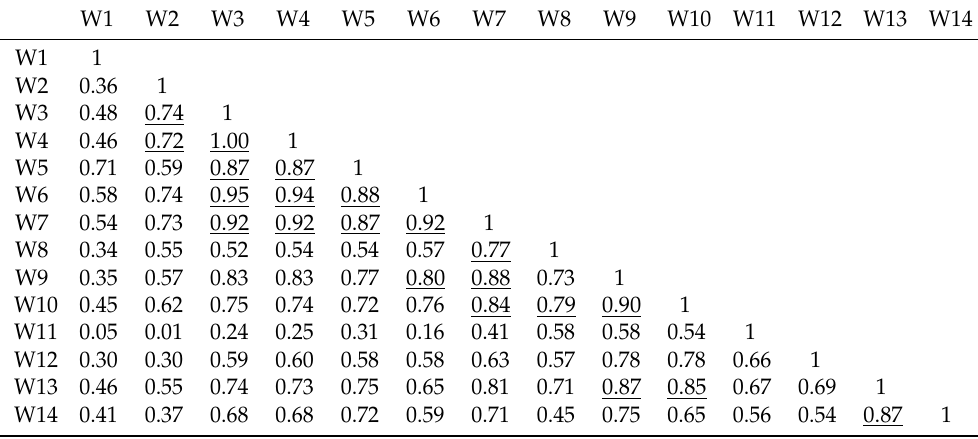
Table 2. Correlation of observation wells with each other in the study